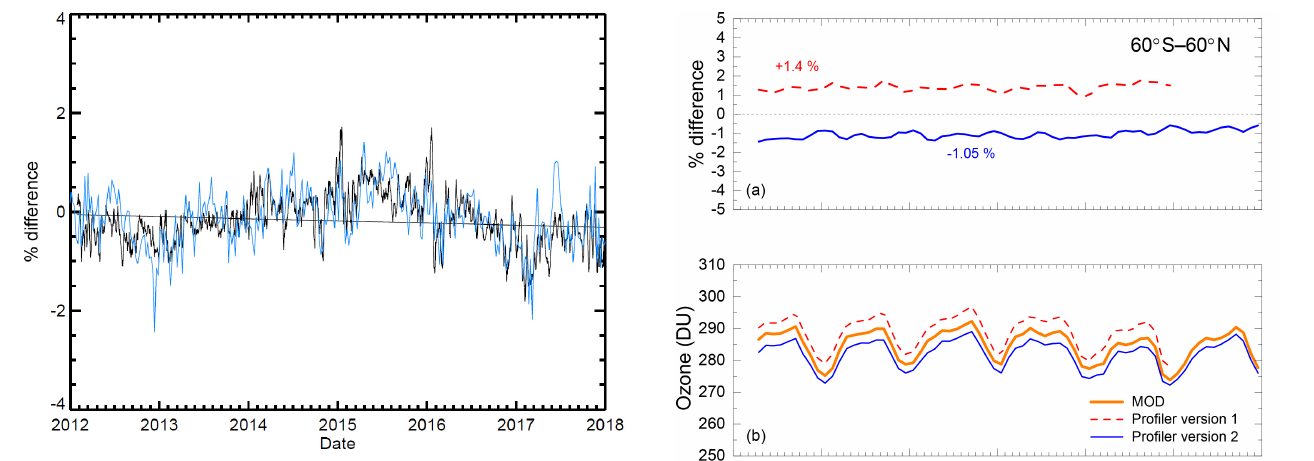
Figure 3. A comparison of OMPS NM ozone (in black) and NOAA 19 SBUV (in blue) with average ozone from an ensemble of 52 Northern Hemisphere Dobson and Brewer stations. A linear fit to the NM data is also shown. Weekly mean percent difference of satel- lite ozone minus ground-based ozone is plotted.